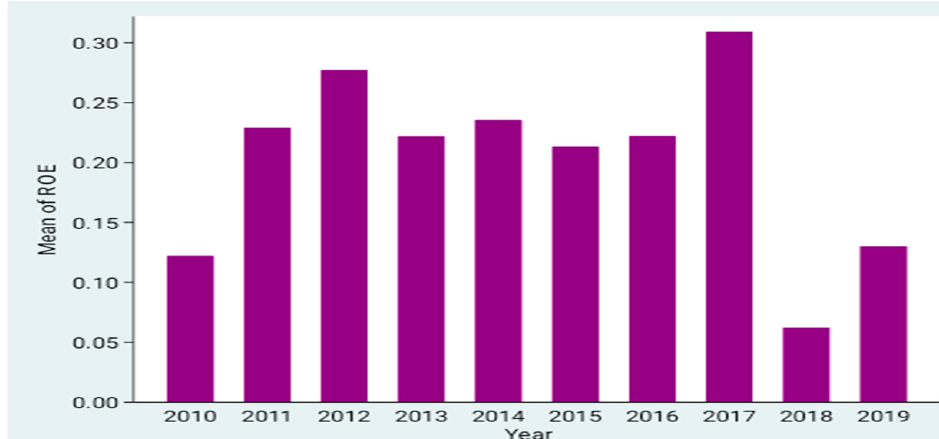
Figure 3. Trends in return on equity.